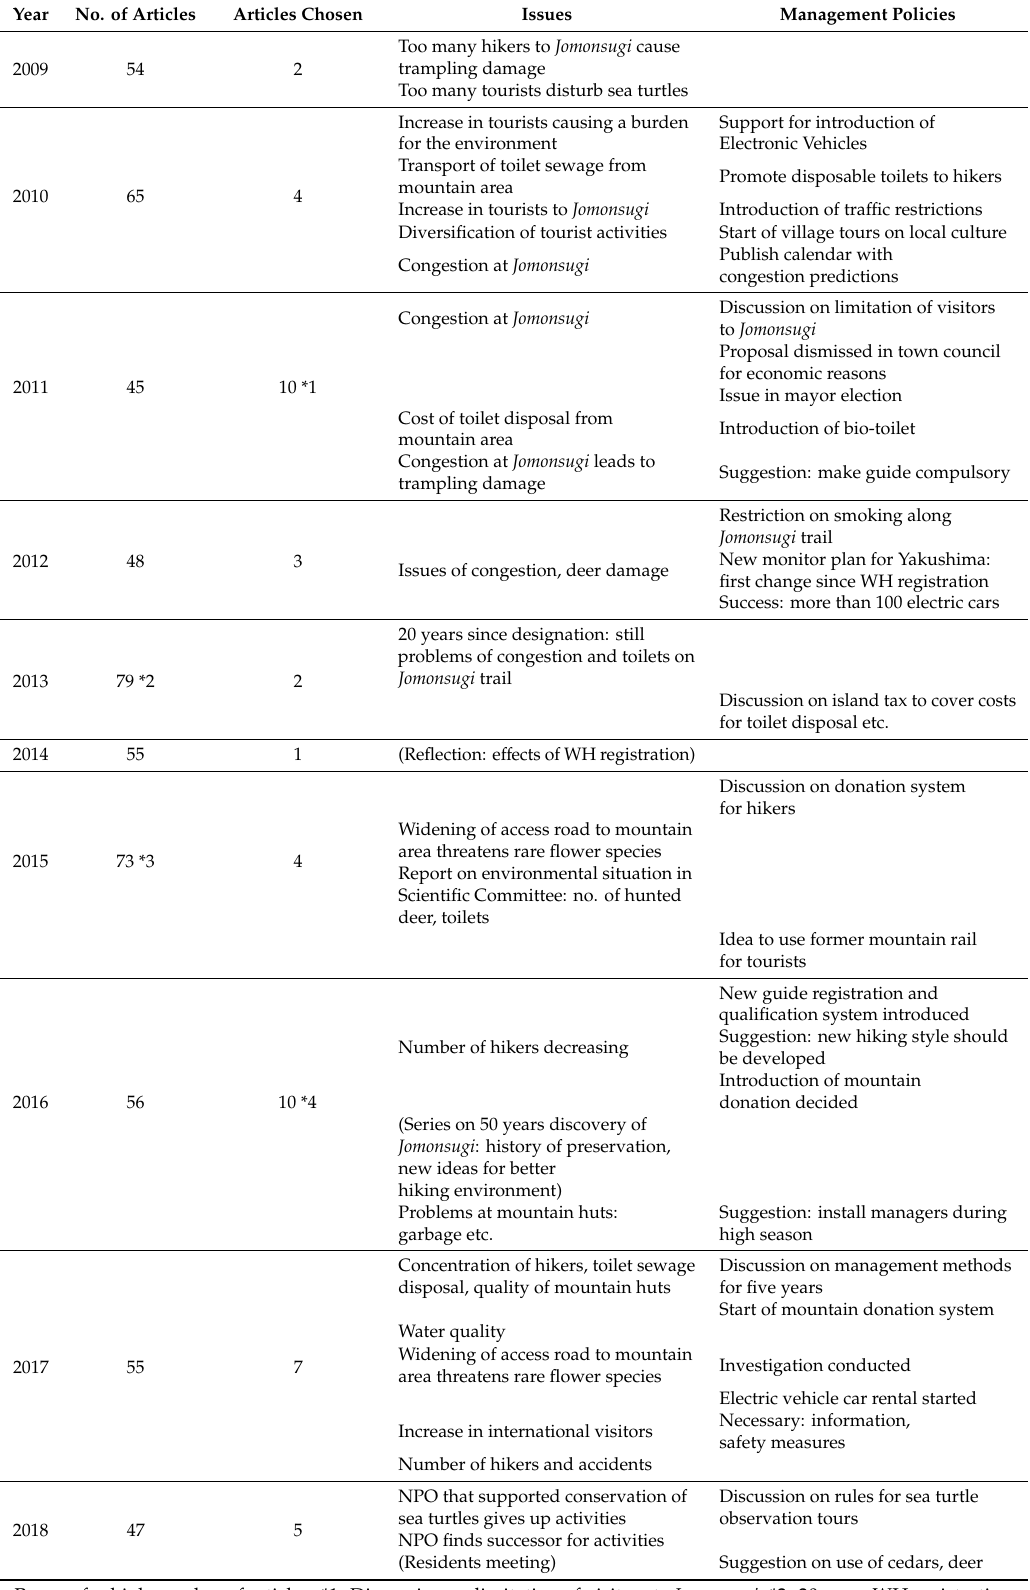
Table 1. List of environmental topics on Yakushima in articles between 2009 and